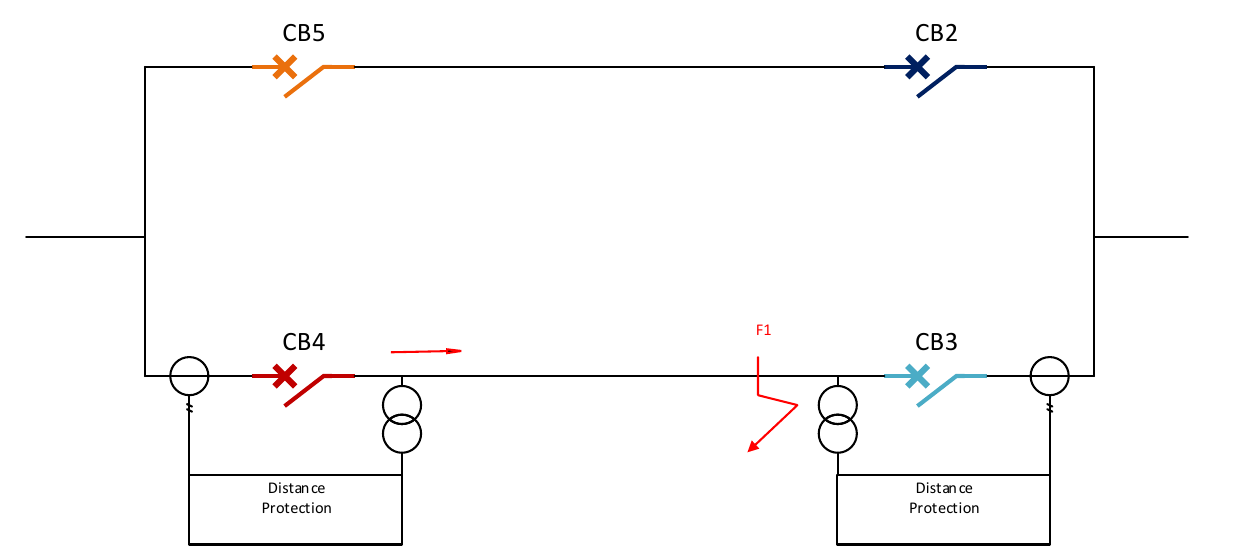
Figure 1. Presence of CBs on all lines in proper relay coordination for accurate fault detection.